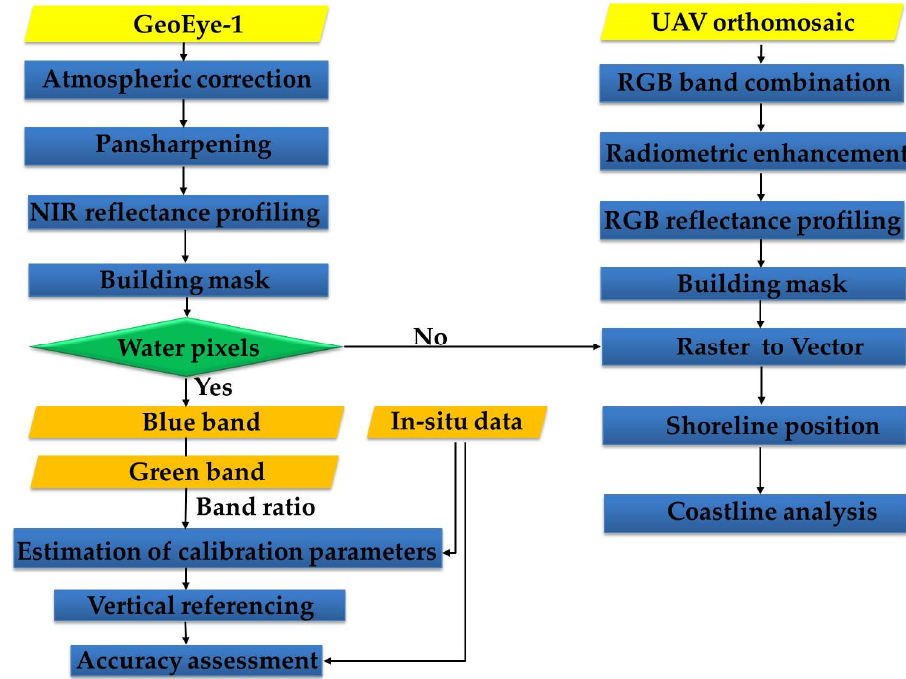
Figure 2. Flowchart, indicating di ff erent steps adopted for satellite-derived bathymetry (SDB) mapping Figure 2 . Flowchart, indicating different steps adopted for satellite-derived bathymetry (SDB) and shoreline mapping and shoreline extraction.